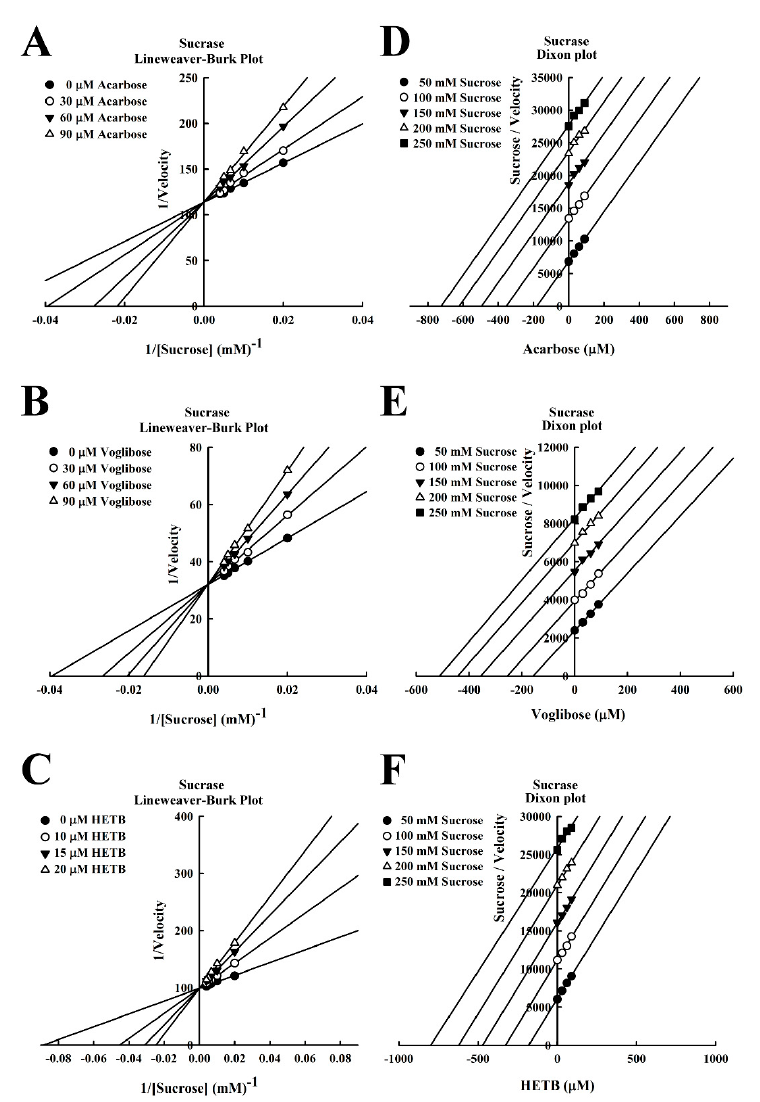
Figure 5. Lineweaver-Burk ( A – C ) and Dixon plots ( D – F ) of inhibitory effect of sucrase inhibitors on sucrase. ( A ) Acarbose, ( B ) Voglibose, ( C ) HETB, and ( D ) Acarbose, ( E ) Voglibose, ( F ) HETB. Each sample was analyzed in triplicate.